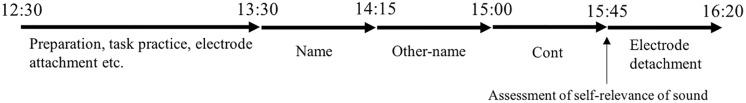
Time schedule of the experiment.Name = name condition, Other-name = other’s name condition, and Cont = control condition (no sound). The order of the conditions was counterbalanced among the participants.